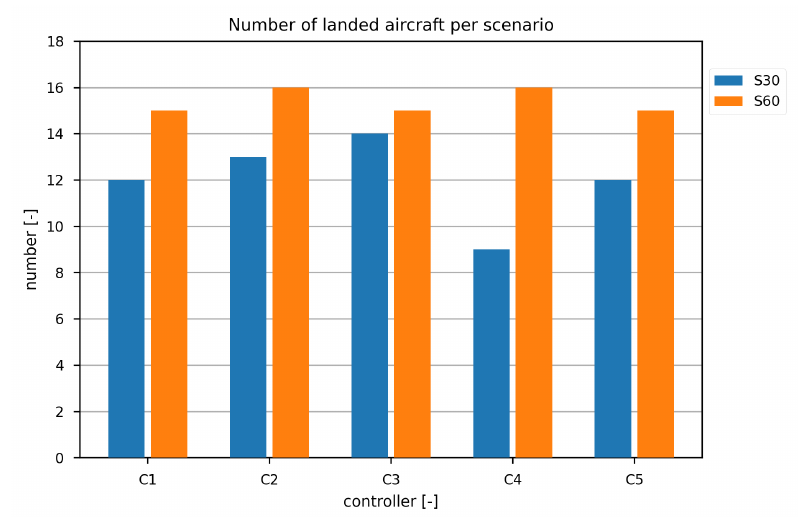
Figure 9. Capacity assessment from validation trials: numbers of landed aircraft listed for five different ATCOs (C1–C5) in each scenario, S30 (blue) and S60 (orange).